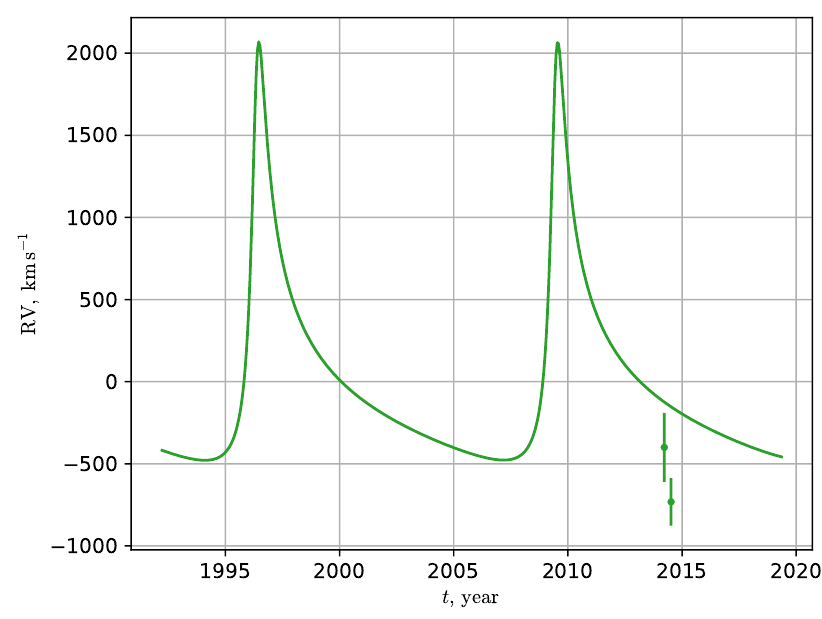
Figure 6. The RV plot of best-fit PPN orbit of